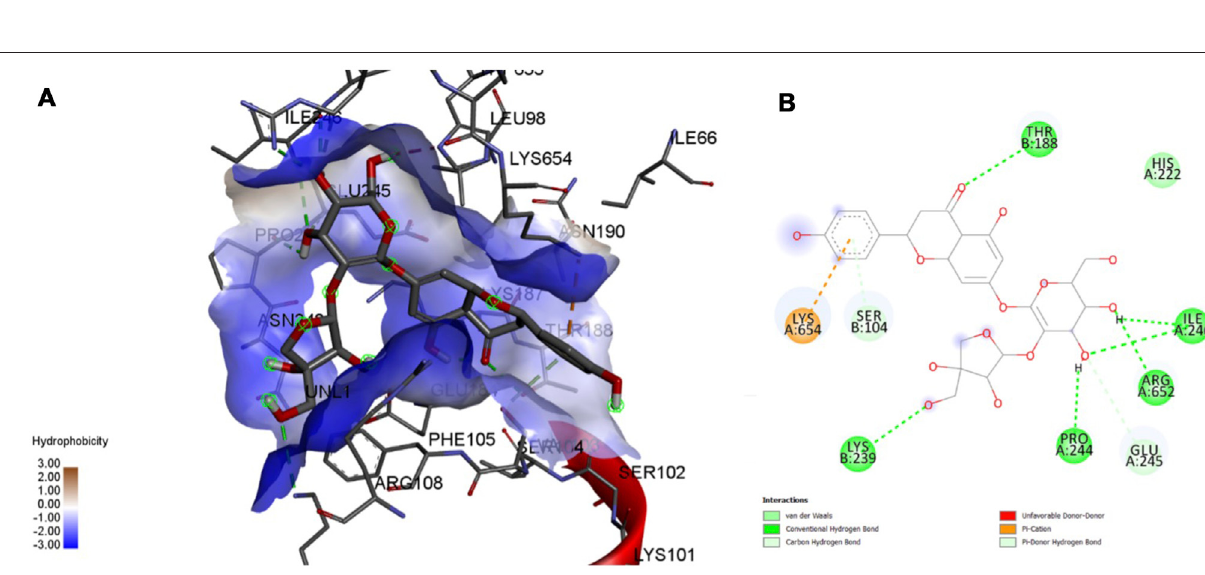
Frontiers in Chemistry |